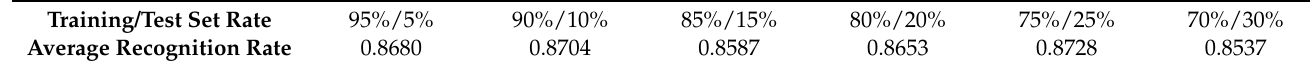
Table 3. Recognition rate in 7 slopes under different test set/verification set ratios.